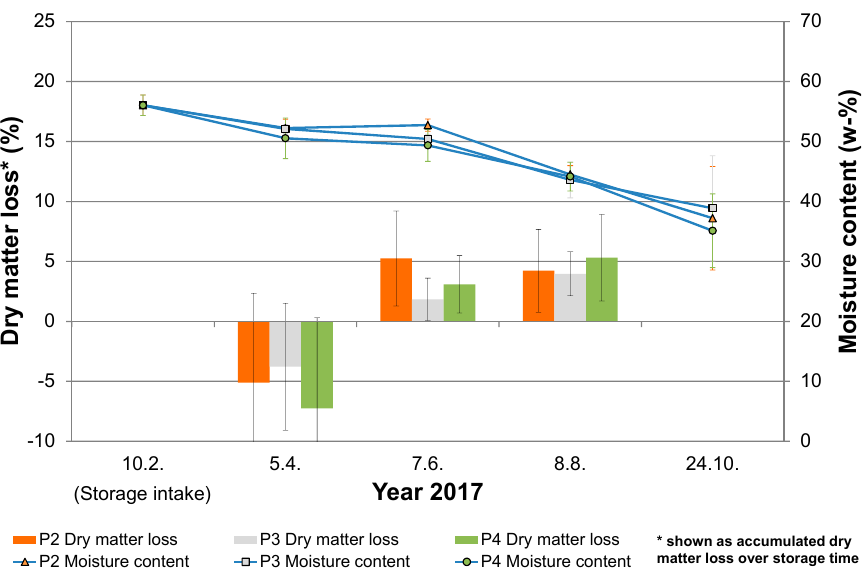
Figure 9. Dry matter losses and moisture contents during storage trials P2–P4 in Schwarzbach.